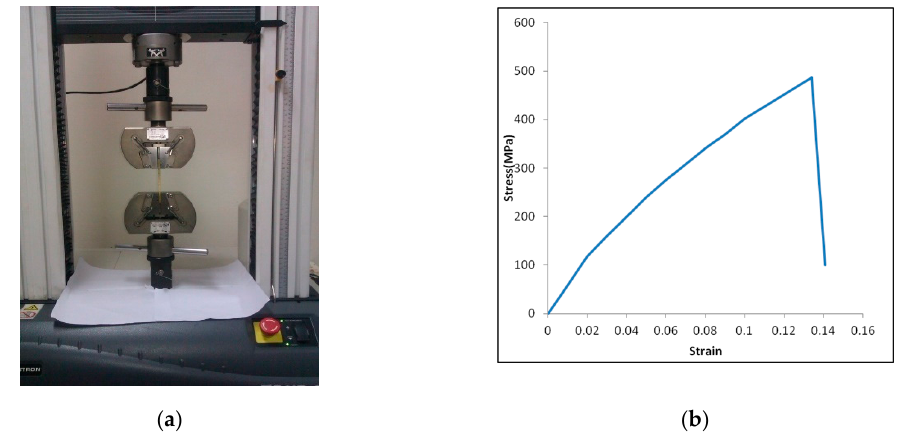
Figure 3. ( a ) Tensile test of GFRP coupon; ( b ) stress–strain curve of GFRP .